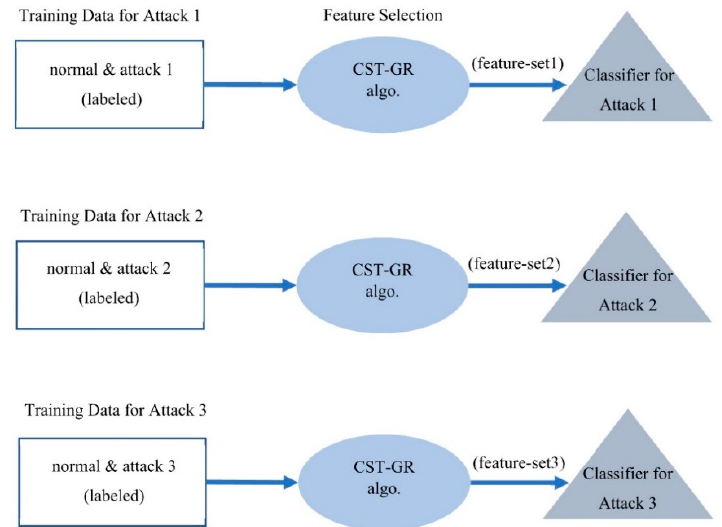
Figure 2. The training phase (the case of three classifiers). CST-GR, correlated-set thresholding on gain-ratio.